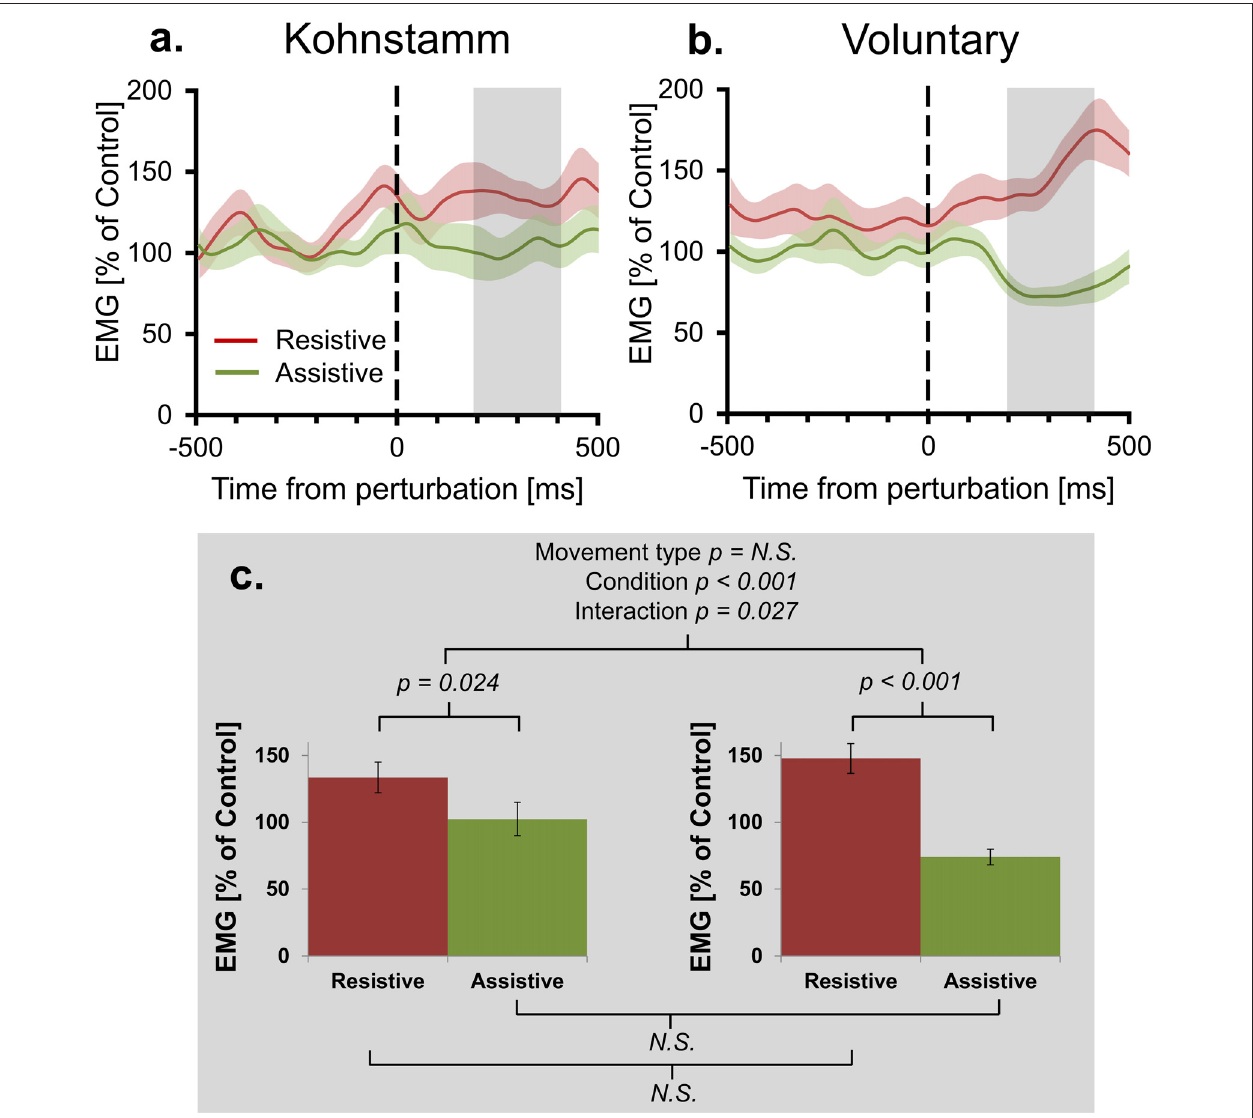
FIGURE 4 | Mean agonist EMG in Resistive and Assistive conditions normalized to No perturbation control condition. Agonist smoothed group EMG (% No perturbation control condition) across conditions, from 500 ms prior to onset of perturbation to 500 ms post-perturbation, for Kohnstamm (A) and Voluntary movements (B) . Note larger difference between perturbation conditions for Voluntary movements. Mean EMG (% No perturbation control condition) 200–400 ms post-perturbation (C) . There was no difference in overall EMG level across movement types. There was larger EMG in the Resistive perturbation condition than in